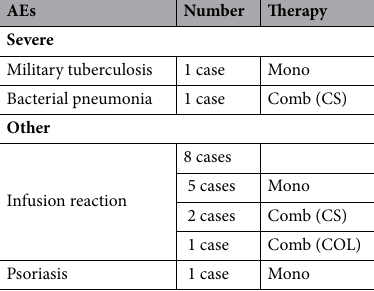
Age range Sex Treatment Reason for discontinuation Duration (months) Treatment after discontinuation of IFX 60 s